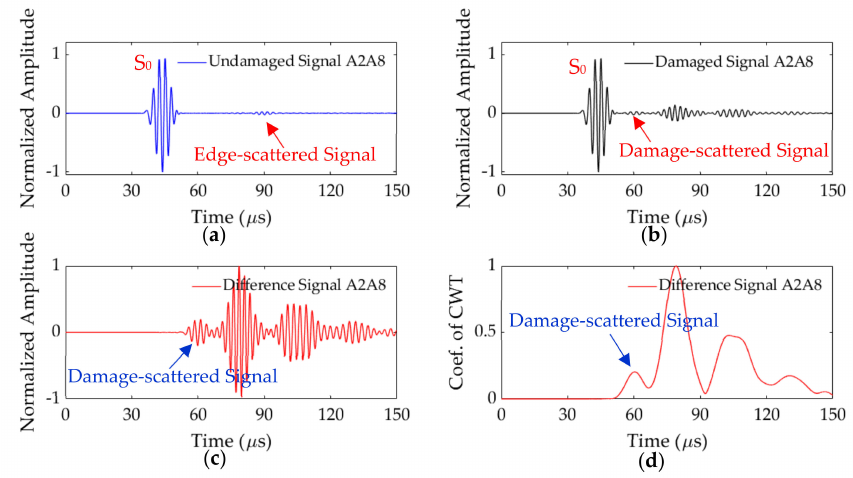
Figure 7. Signals for sensing path A2A8: ( a ) undamaged; ( b ) damaged; ( c ) di ff erence; ( d ) coe ffi cient of